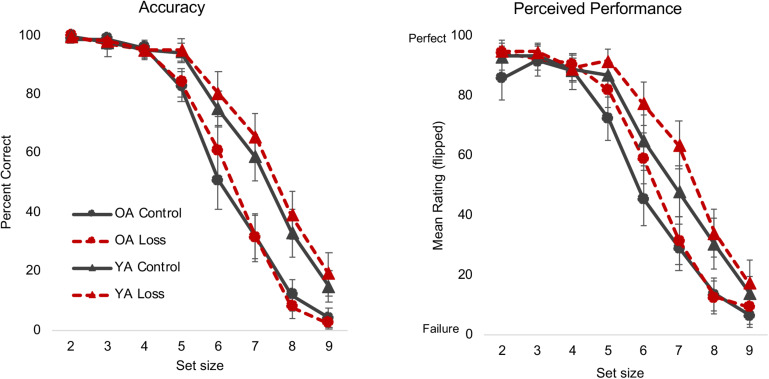
Letter Number Sequencing (LNS) accuracy and NASA-TLX perceived performance ratings. Different colors/lines (control = black solid line, loss = red dashed line) and shapes [triangle = young adults (YA), circle = older adults (OA)] are used to highlight the different conditions. Error bars represent 95% confidence intervals. The loss incentive did not affect actual performance (left panel) but did increase participants’ self-report ratings of their perceived performance (right panel). See text and Table 3 for statistical details for this and other figures. NASA-TLX, NASA Task Load Index.